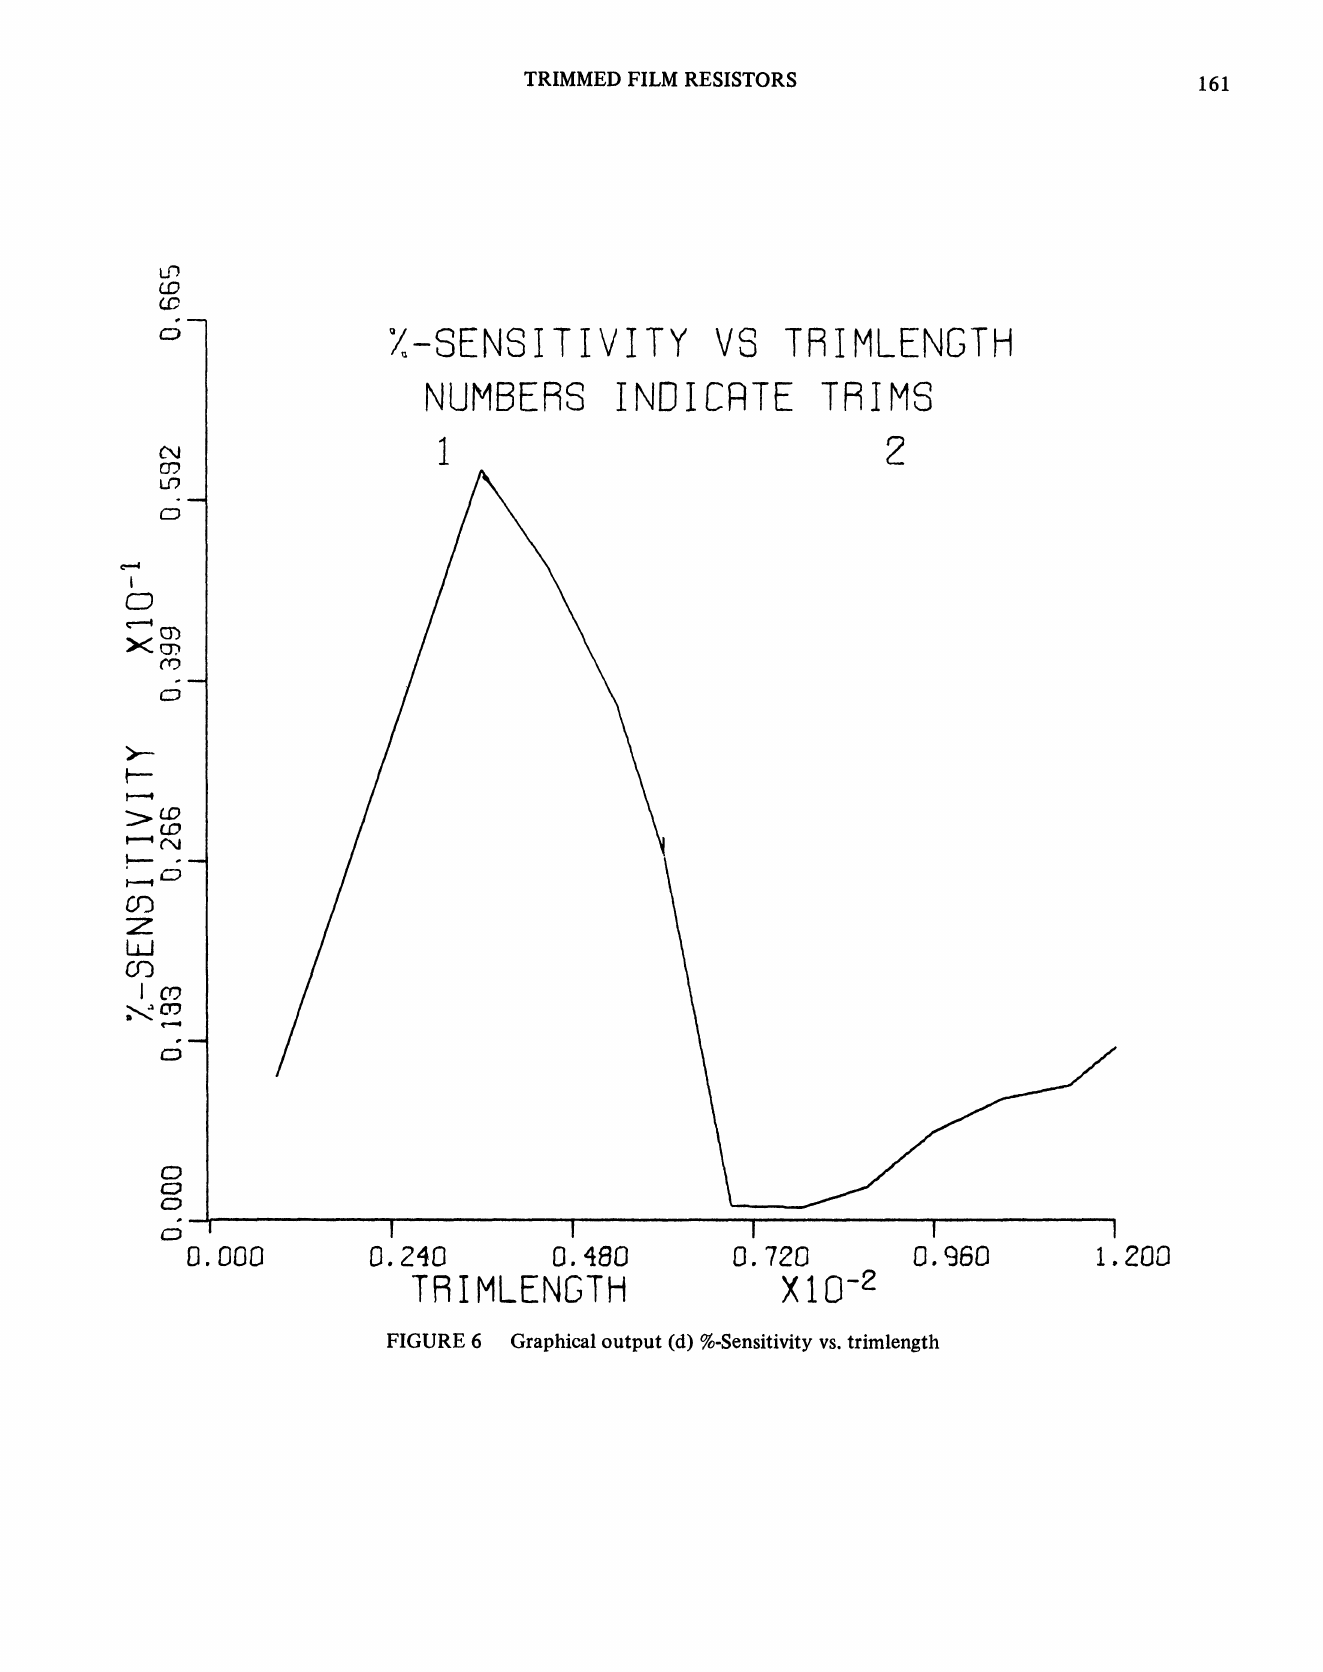
Graphical output (d) %-Sensitivity vs.